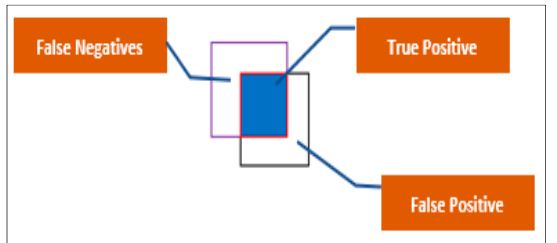
Figure 9. True positive, false positive and false negative. Here, the purple square is the ground truth and the black square represents the detected region.